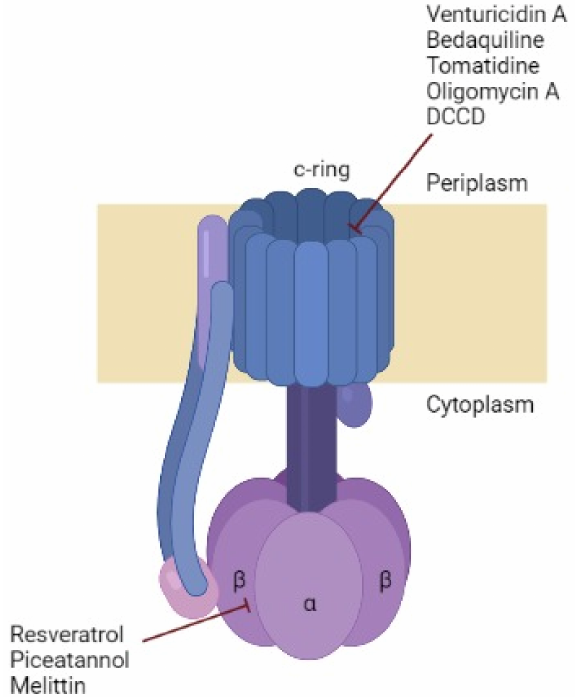
Figure 4. Bacterial ATP synthase composition and the subunit targeted by some inhibitors. ATP synthase represents the typical structure identified in bacteria. The number of monomers in c-ring differs between organisms. The inhibitory sites of each inhibitor are showed in red. Made with